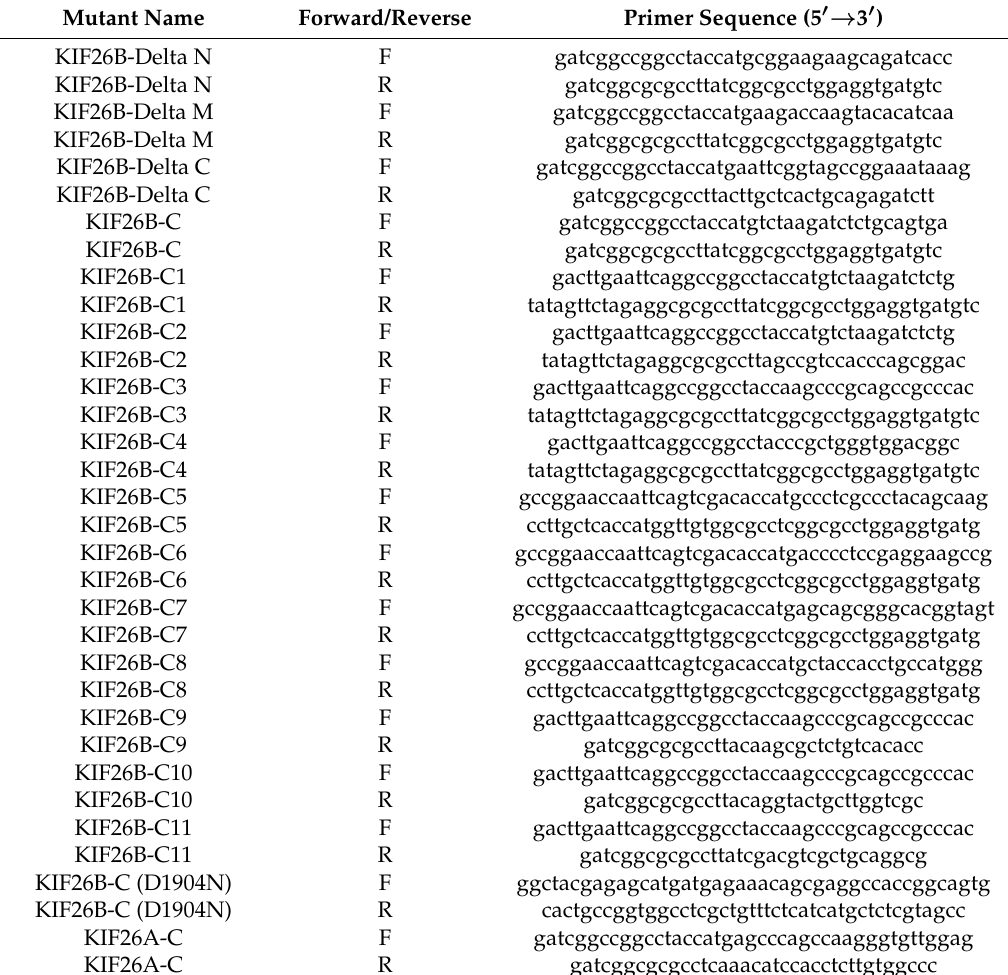
Table A1. List of primers used to generate mutant variants of KIF26B and KIF26A